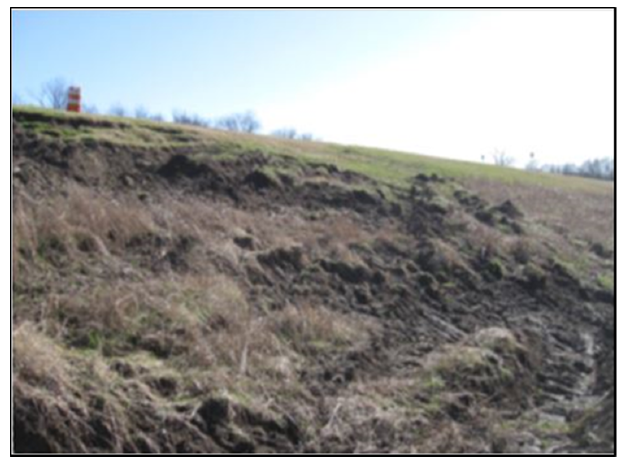
Figure 2. Slough or slump slide on a levee.